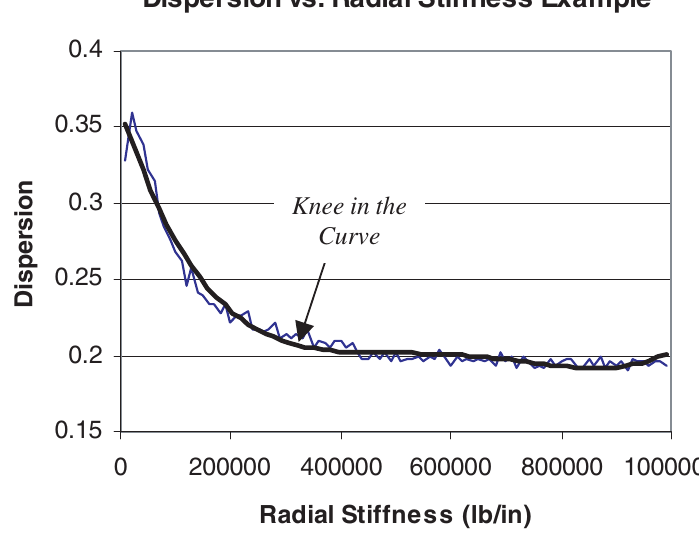
Fig. 6. Example of sabot front borerider stiffness vs. total dispersion.